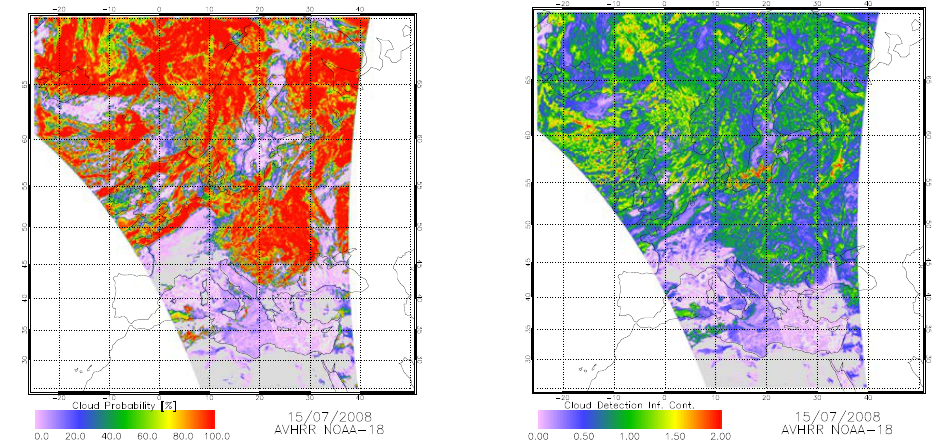
Figure 5. Cloud probability (left) and cloud detection information content (right) from AVHRR on NOAA-18 for 15 July 2008.